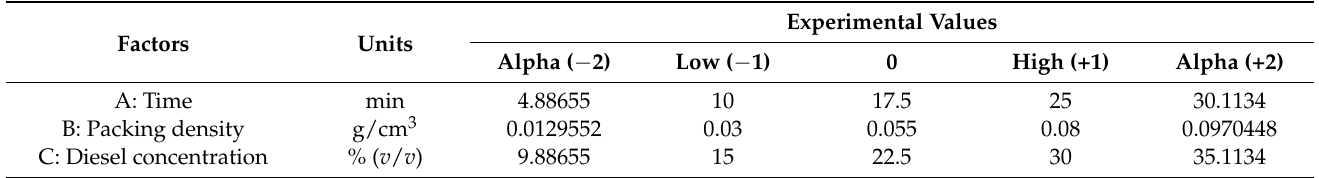
Table 8. CCD design for experimental values and the five coded levels of three significant factors analysed for the efficiency of diesel and seawater